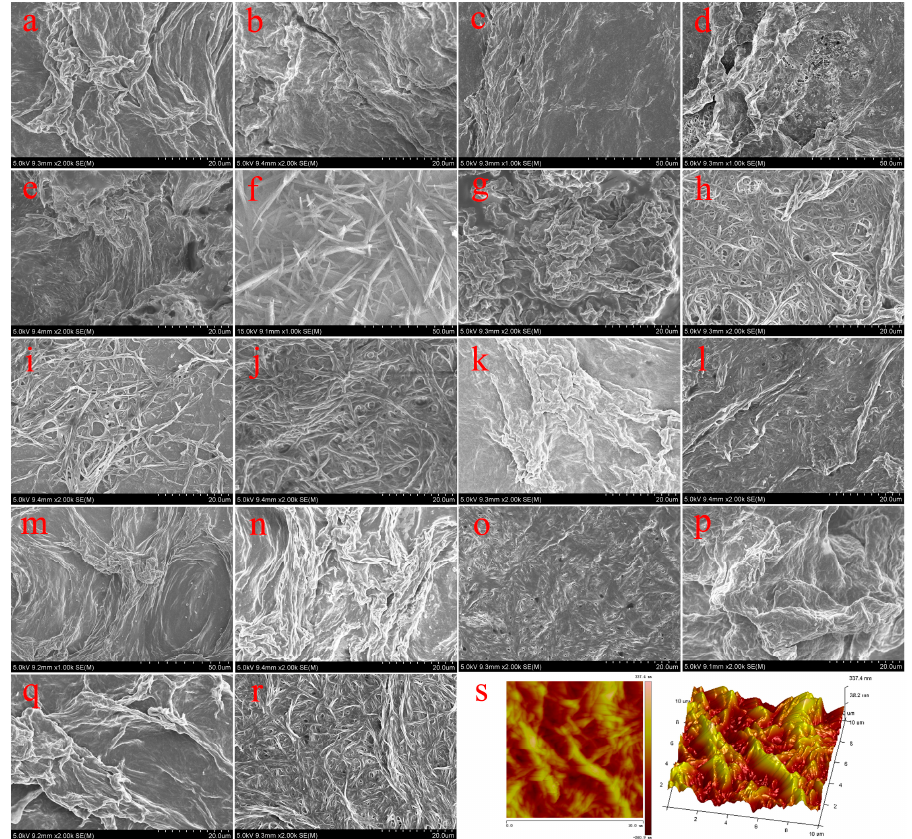
Figure 5. SEM images of TC16-Fl xerogels from gels in various solvents: ( a ) nitrobenzene; ( b ) acetone; ( c ) DMF; ( d ) aniline; ( e ) pyridine; ( f ) petroleum ether; ( g ) n-hexane; ( h ) ethanol; ( i ) n-propanol;